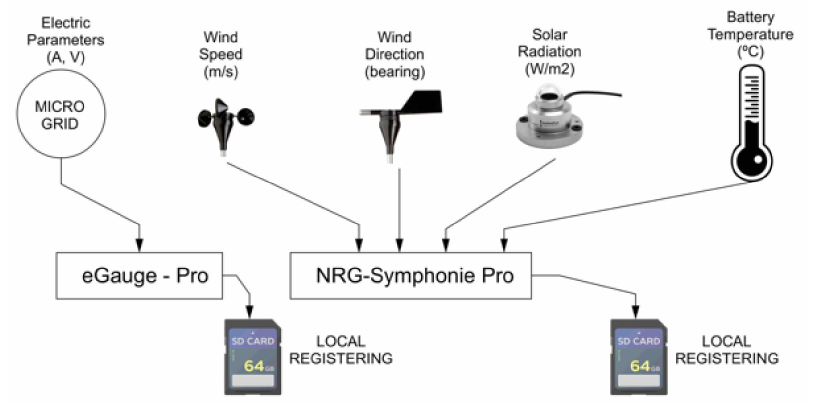
Figure 4. General setup for data collection and registering.